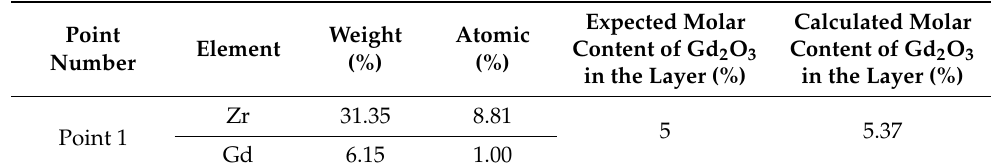
Table 3. Average chemical composition performed by EDS point analysis at point 1 shown in Figure 6a.